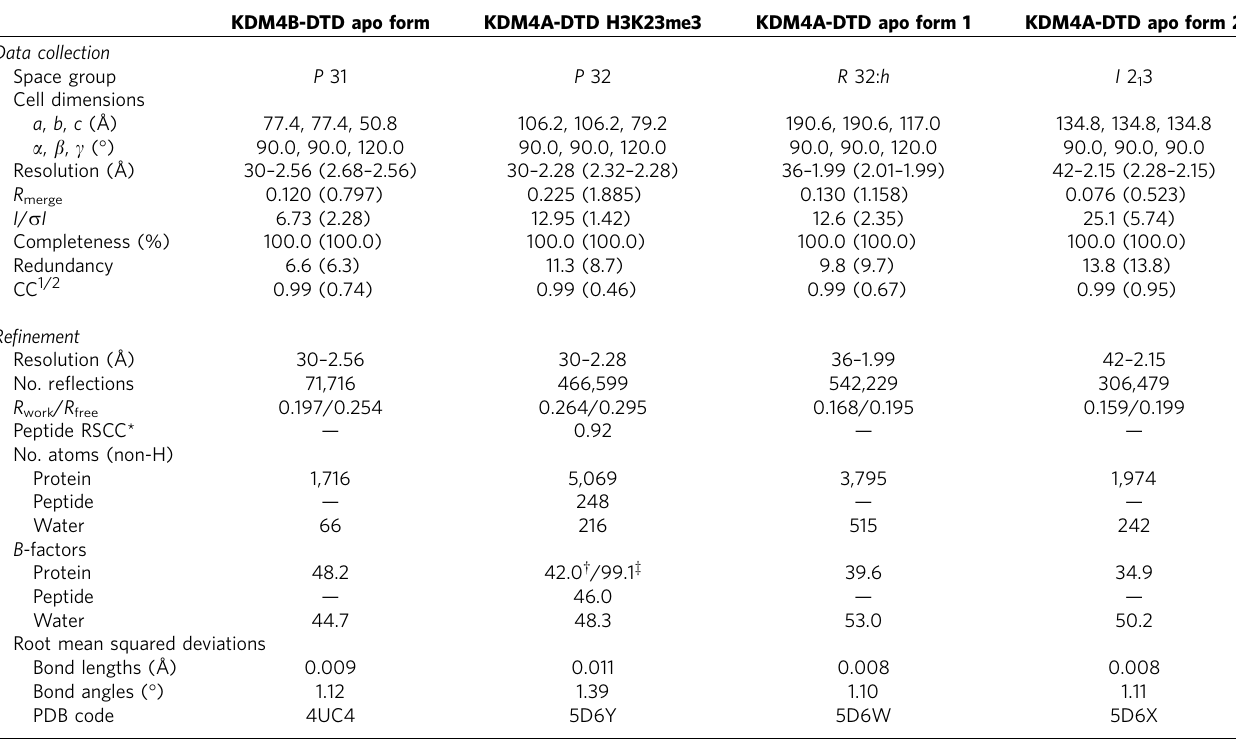
Table 1 | Data collection and refinement